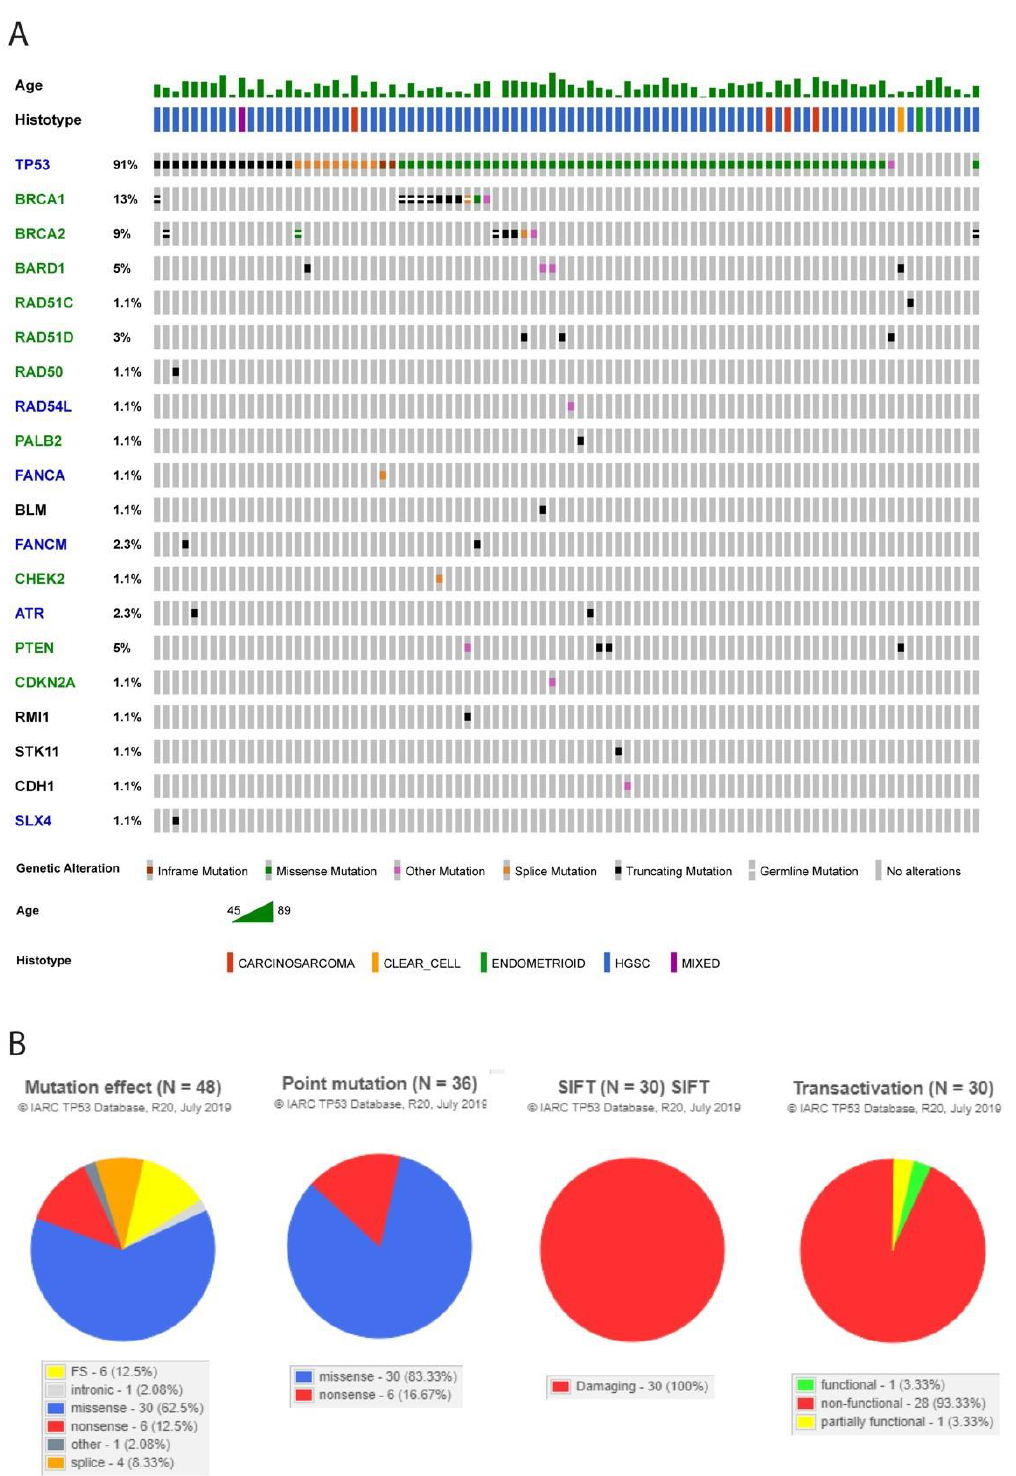
Figure 2. ( A ) Oncoprint of genomic alterations in the cohort. The text colour of the gene reflects the availability of targeted therapy, with the green text indicating an FDA approved drug, blue text indicating a drug in clinical trials, and black text indicating a gene related to an hereditary syndrome. ( B ) Detailed characteristics of the TP53 loss of function mutations identified in the cohort. From left to right, these pie charts indicate (1) the mutation effect, (2) whether the point mutations are missense or nonsense, (3) whether the mutation was damaging by the SIFT analysis, and (4) the effect of the mutation on transactivation. These parameters may serve as markers of response to adavosertib, as discussed in the